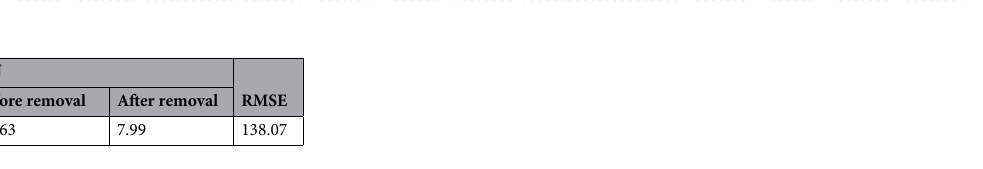
Table 3. Evaluation of denoising of multi-frequency